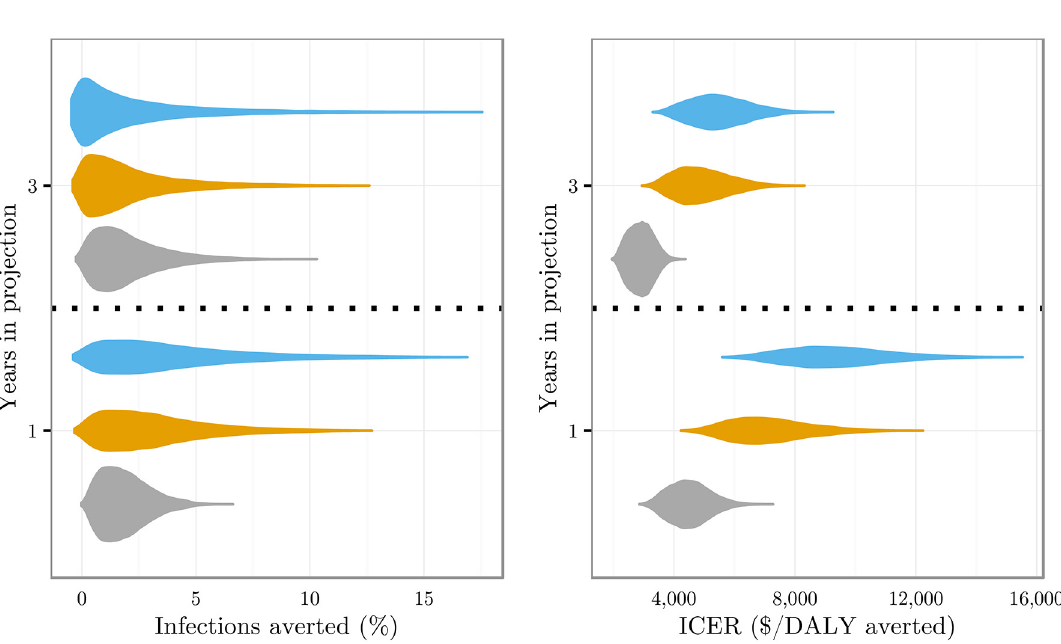
Fig 2. Violin plots showing infections averted and ICERs when introducing POC CD4 testing compared to laboratory testing in each care context. Left plot shows infections averted across one and three year projections. The right plot shows ICERs. The colours correspond to (from bottom to top in each year): grey — current care (CC) context, orange — enhanced counselling and testing (ECT), blue — universal test and treat (UTT). Note: when linkage to care is high but the effectiveness of ART in reducing infectivity is low (close to 50%), patients live longer and have more opportunity for transmission than would be the case without the introduction of POC CD4 testing. This results in the observed negative infections averted but, since more individuals are on treatment, DALYs averted (and so ICERs) are still positive.